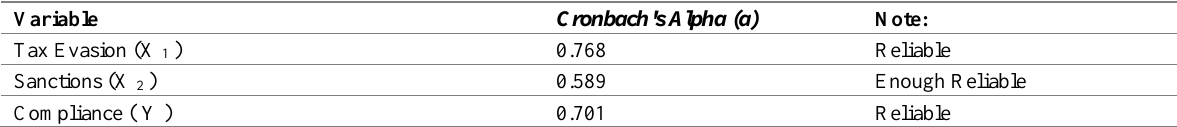
Table 3: Reliability Test Results